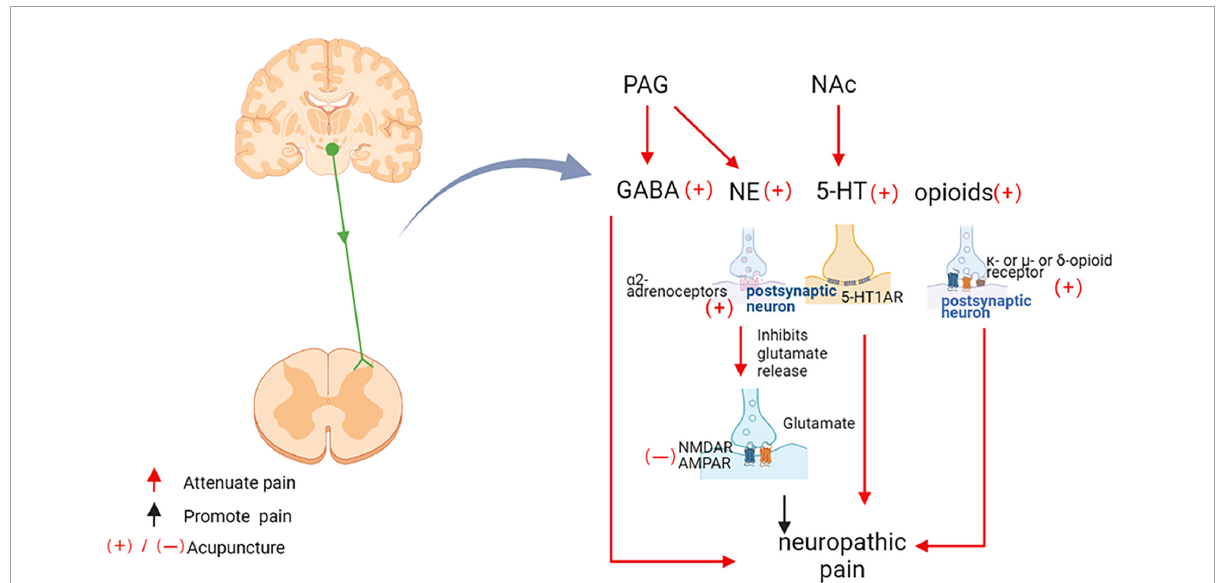
FIGURE7 Acupuncture inhibits neuropathic pain through the downstream pathway. PAG, periaqueductal gray matter; nucleus accumbens, NAc; GABA, Gama aminobutyric acid; NE, Norepinephrine; 5-HT, 5-hydroxytryptamine; 5-HT1AR, 5-hydroxytryptamine 1A receptors; 5-HT3R, 5-hydroxytryptamine 3 receptors; NMDAR, N -methyl-D-aspartate receptors; AMPA, α -amino-3-hydroxy-5-methyl-4-isoxazolepropionic acid